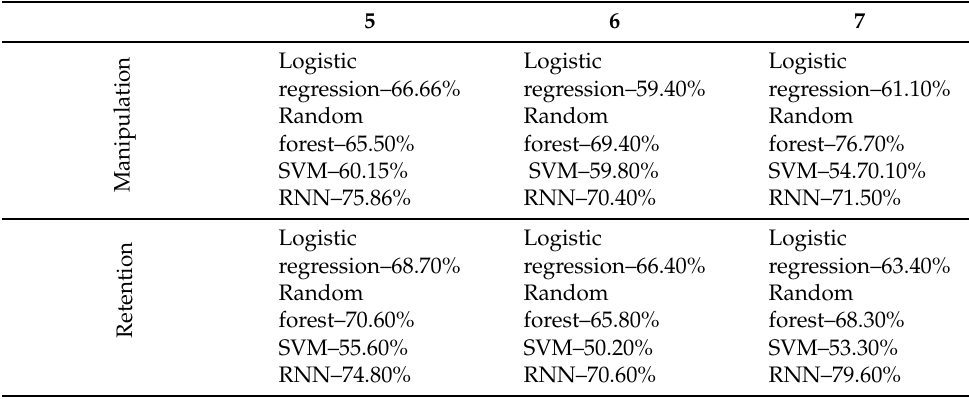
Table A2. Accuracy of Classifying Verbal Memory Task Conditions 5, 6 or 7